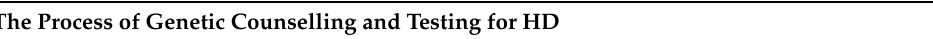
Table 1. The process of genetic counselling and testing for HD, adapted from [21]. Abbreviations: CAG—cytosine, adenine,